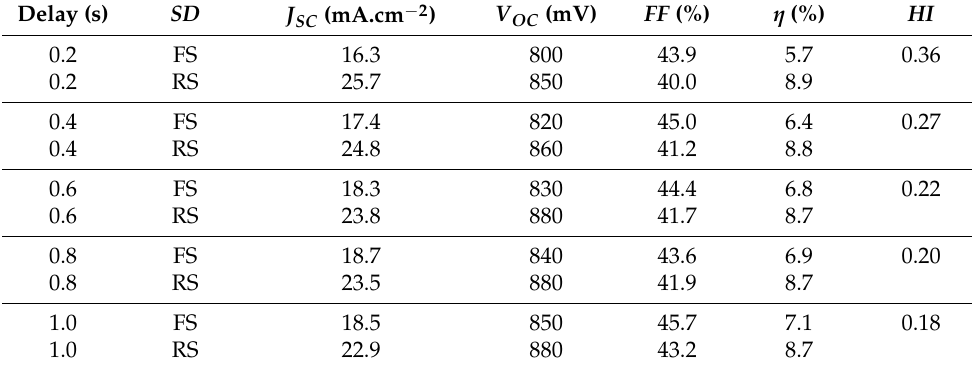
Figure 2. Current density–voltage ( J–V ) hysteresis characteristics of the device measured under standard AM 1.5G illumination (100 mW.cm − 2 ) at forward scan (FS: scan direction from − 1 to 1 V) and reverse scan (RS: scan direction from 1 to − 1 V) at different time delays. Table 1. Sweep voltage scan direction and sweep-time-delay-dependent photovoltaic parameters of the TiO 2 /CH 3 NH 3 PbI 3 heterojunction HTM-free monolithic perovskite solar